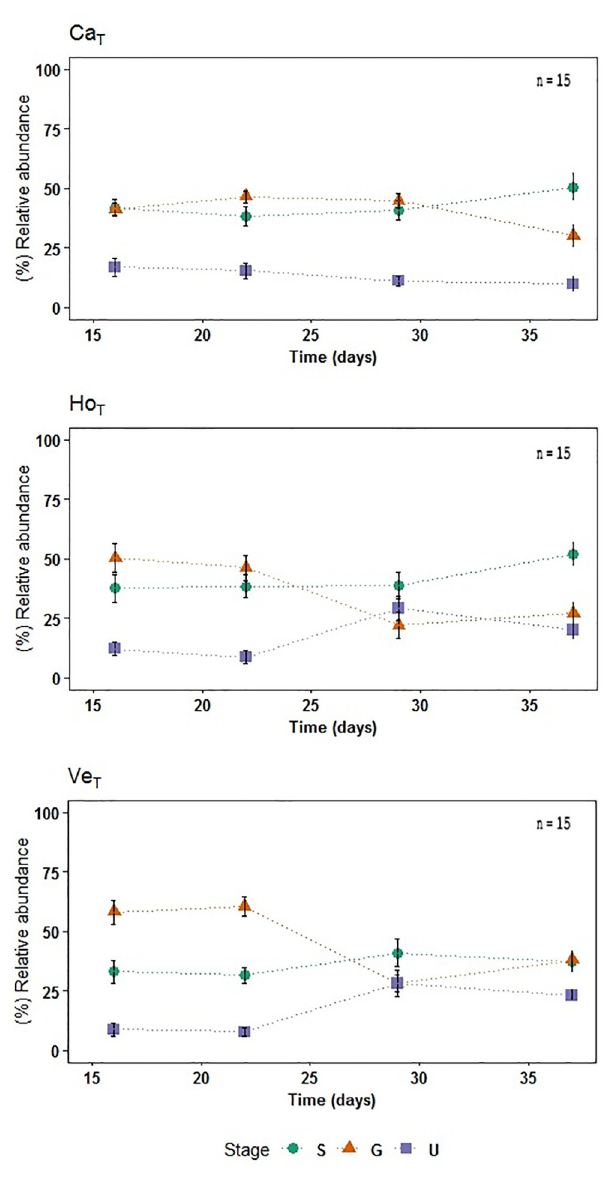
Fig 7. Gametophyte development. Development from settled spores to undifferentiated gametophyte during 37 days of exposure to the treatments, showing SD (n = 15). The legend indicates the following life cycle stages: Spores (S), Spores with germ tube (G) and Undifferentiated gametophyte (U) (Fig 3A–3C). Ca; Cachagua, Ho; Horco´n, Ve; Ventanas. T; treatment.